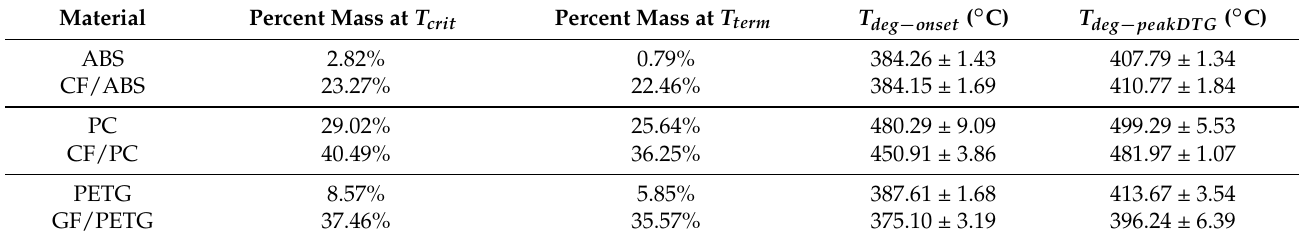
Figure 5. Mass loss % (left axis) and DTG (right axis) of ( a ) ABS; ( b ) CF/ABS; ( c ) PC; ( d ) CF/PC; ( e ) PETG; and ( f ) GF/PETG. S1, S2, and S3 correspond to sample 1, sample 2, and sample 3, respectively. Table 3. Summary of TGA results. T crit refers to the temperature at the end of the single-stage degradation, while T term is the temperature at the end of the test. The degradation temperature was measured for all the samples as the on-set temperature of the mass loss percentage versus temperature curve ( T deg onset ) and peak of the derivative of the mass loss percentage versus temperature curve − ( T deg peakDTG −